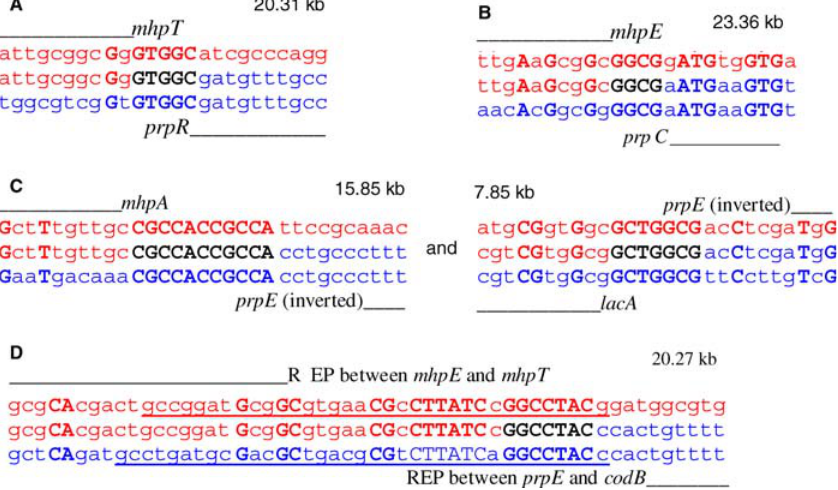
Figure 2. Examples of Novel Junction Sequences in Their Context See Table S1 for similar context information for all 31 junctions sequenced. One parental sequence with its gene designation is in red on the top line, the other in blue on the bottom line. The novel sequence is in the middle, with the junction sequence shown in black. Bold uppercase letters indicate identity between the parental sequences. The distances between the junction sequences on the parental chromosome are given in kb. REP repeated sequence elements are underlined. Strains used are as follows: (A) PJH4; (B) PJH23 and PJH37; (C) PJH39, the only complex amplicon, containing a direct and an inverted repeat, and hence two junctions; and (D) PJH32, an isolate with a REP repeated sequence element at the junction. DOI: